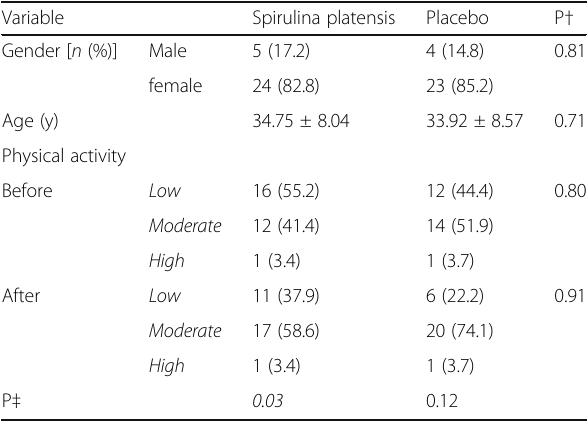
Table 2 General characteristics of study participants Variable